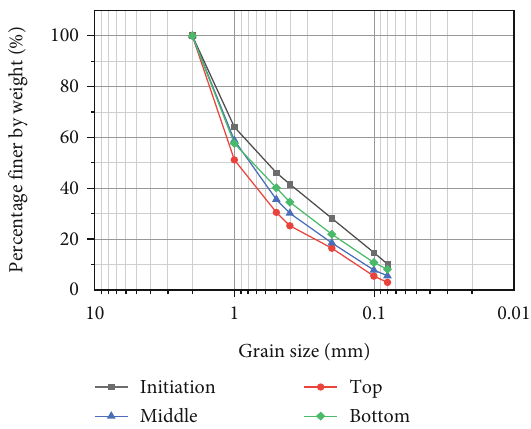
Figure 13: Test number 6 particle grading variation curves before and after